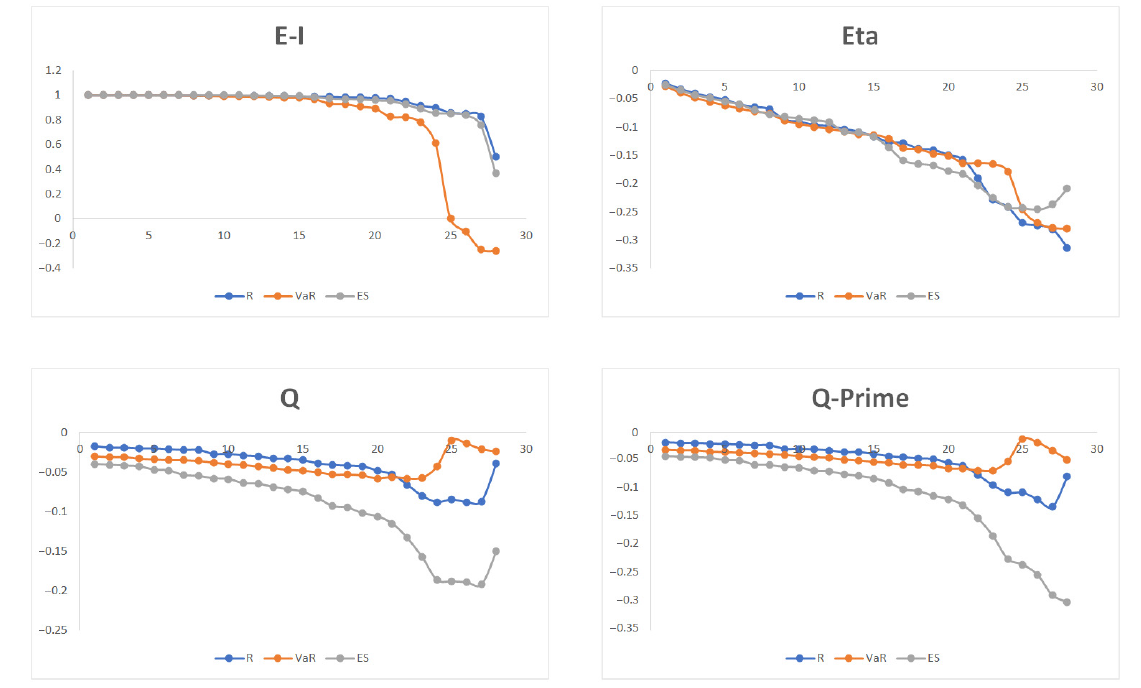
Figure 7. Measures of Cluster Adequacies for Networks 𝑁 (cid:3045) , 𝑁 (cid:3049)(cid:3028)(cid:3045) and 𝑁 (cid:3032)(cid:3046)